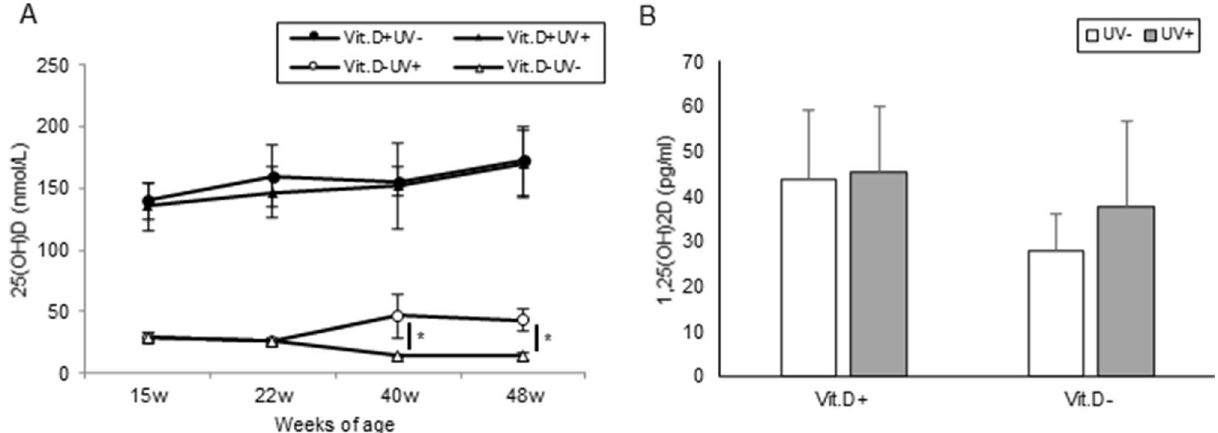
Figure 5. Serum levels of 25(OH)D and 1,25(OH)2D in main study. Sera for 25(OH)D examination were collected at 15 weeks of age, 22 weeks, 40 weeks (16-weeks of UV irradiation), 48 weeks (24-weeks of UV irradiation). Sera for 1,25(OH)2D examination were collected at 48 weeks (24-weeks of UV irradiation). ( A ) Serum levels of 25(OH)D. ( B ) Serum levels of 1,25(OH)2D. * p < 0.05. Vit.D − vitamin D-deficient diet; Vit. D + vitamin D-replete diet; UV ultraviolet